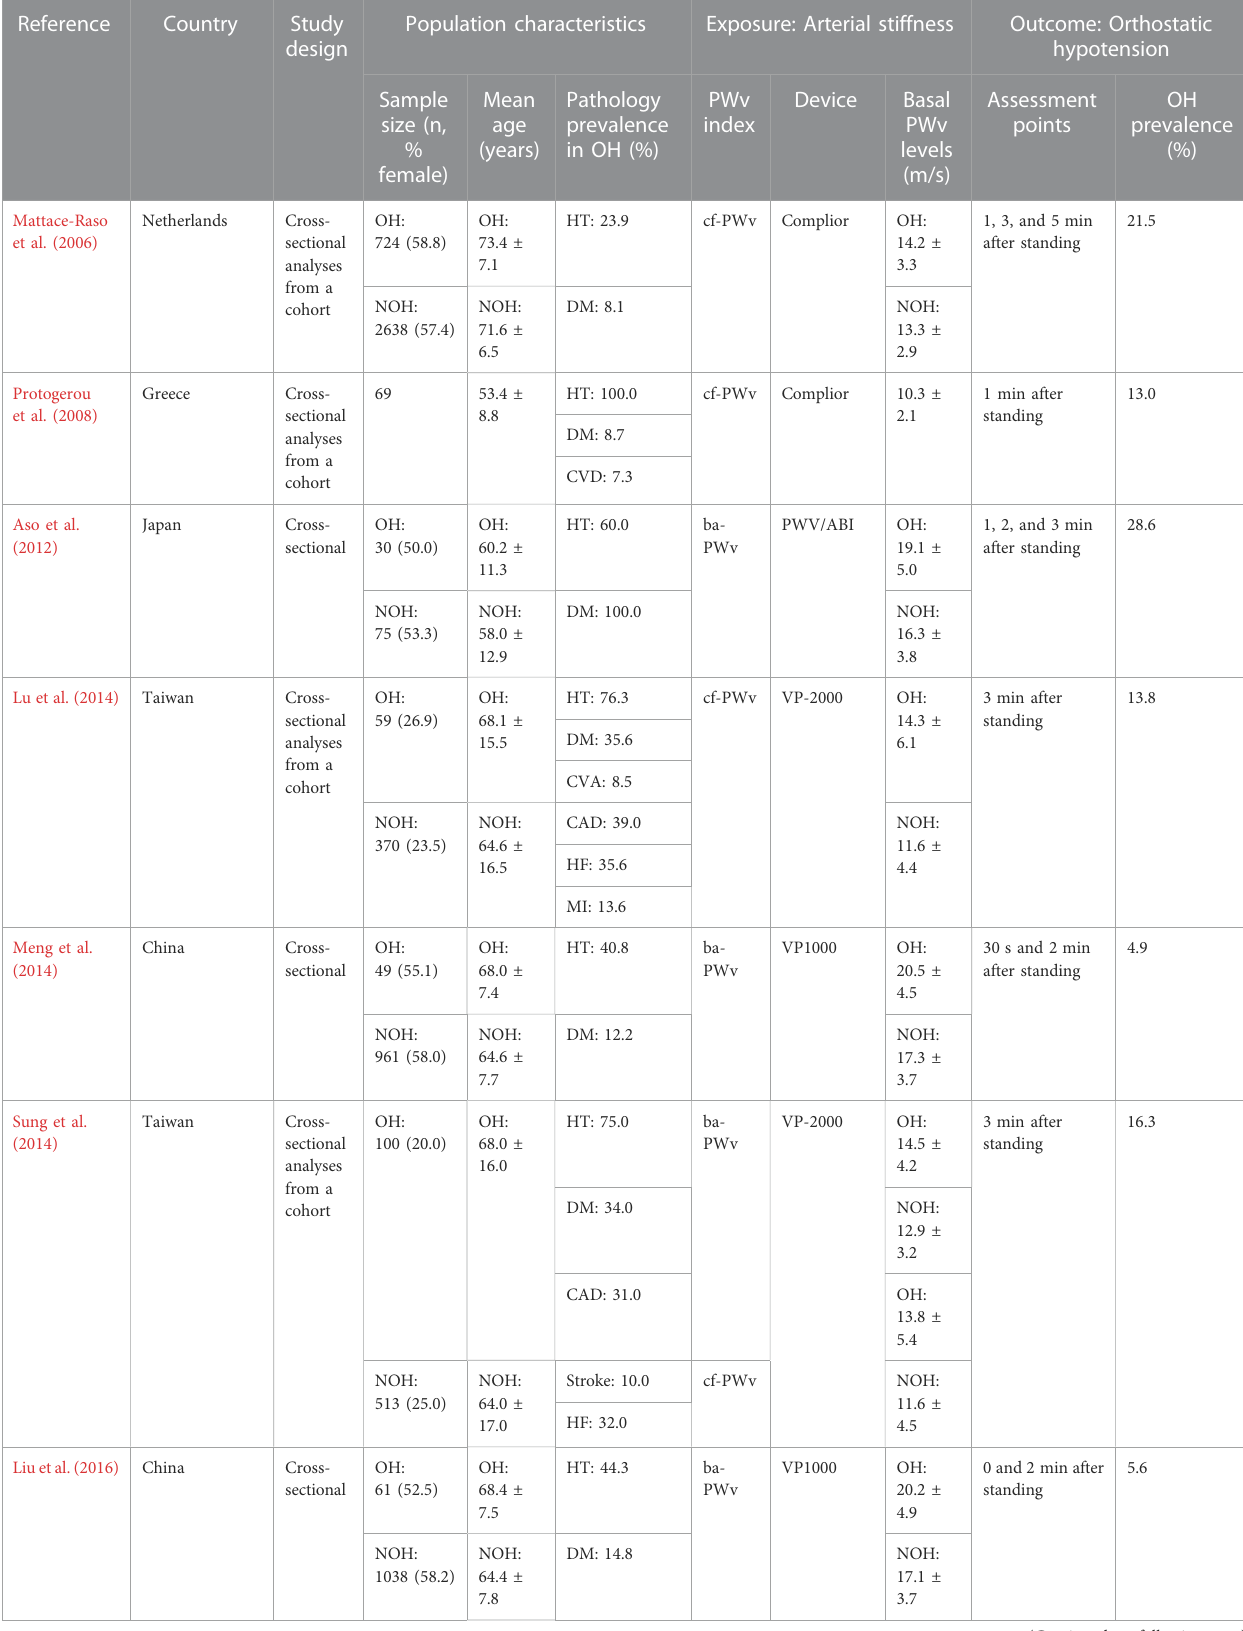
TABLE 1 Characteristics of the included studies in the systematic review and